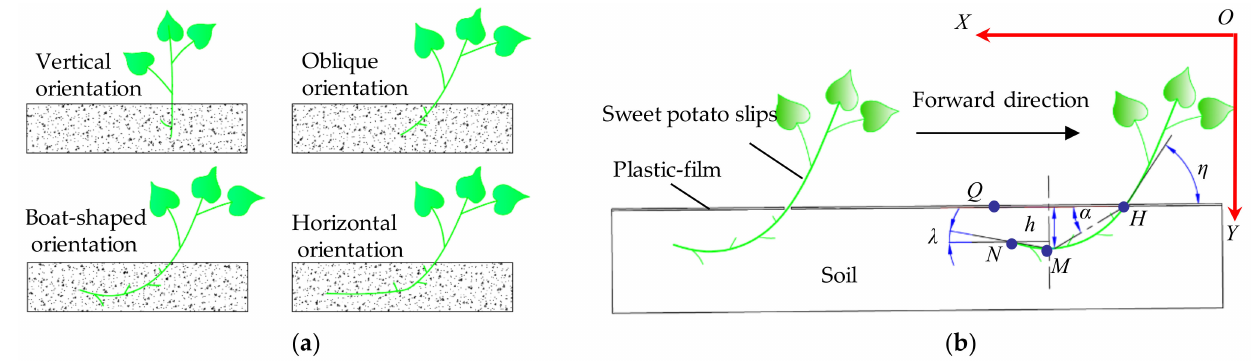
Figure 2. Model of planting sweet potato slips by boat-shaped placement. ( a ) Placement of sweet potato slips at planting; ( b ) Model of planting sweet potato slips by boat-shaped